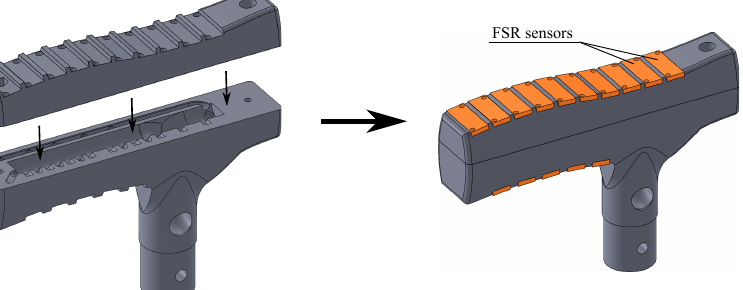
Figure 2. CAD handle design with the FSR sensors in orange.